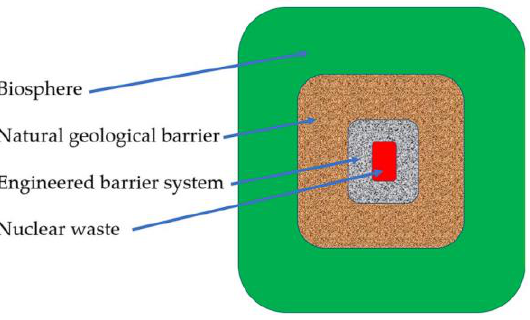
Figure 1. Illustration of the multiple-barrier safety principle for GDF [1].